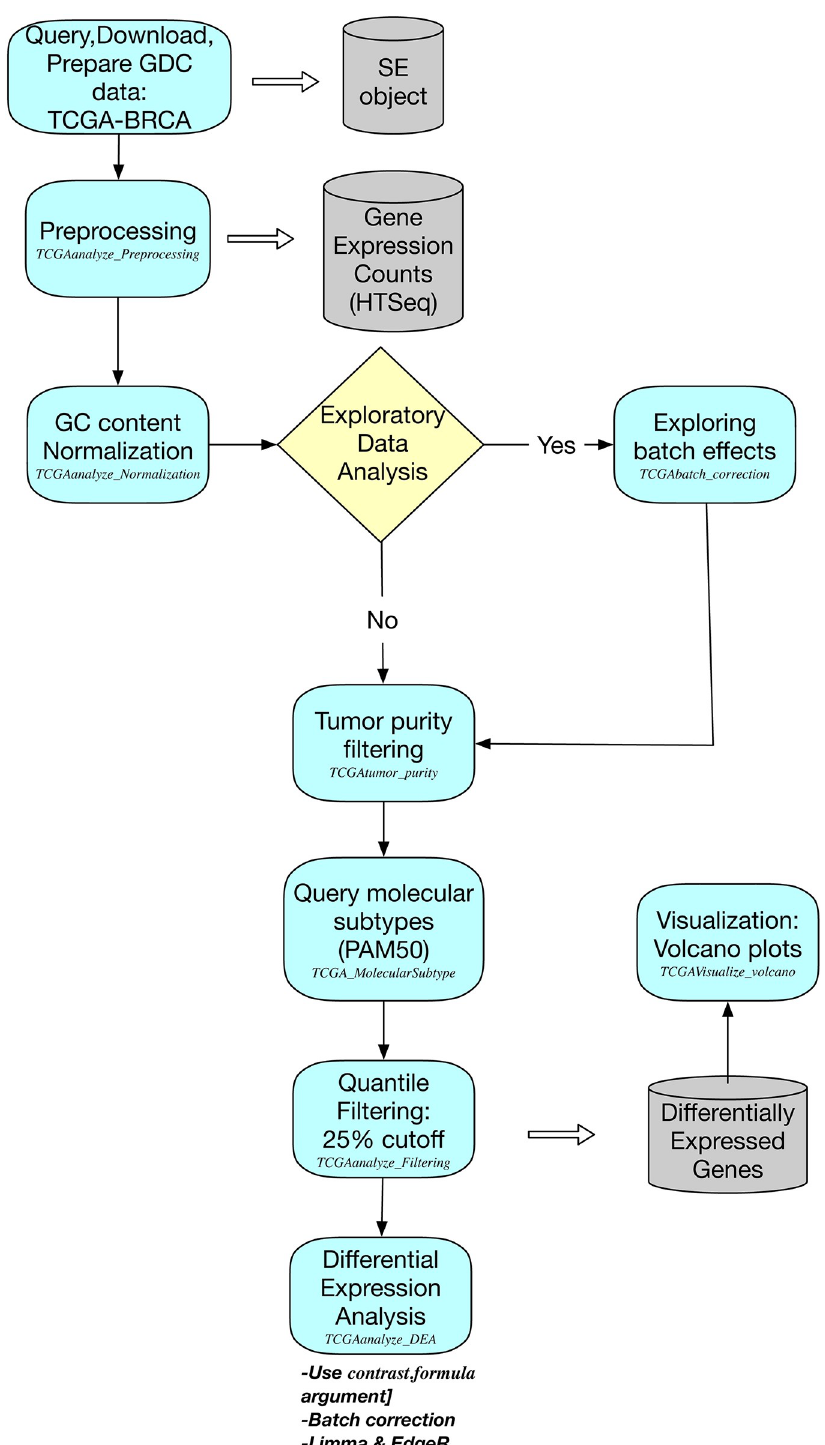
Fig 2. The workflow illustrates the steps and TCGAbiolinks functions to be used for case study 1 on TCGA-BRCA luminal subtypes.